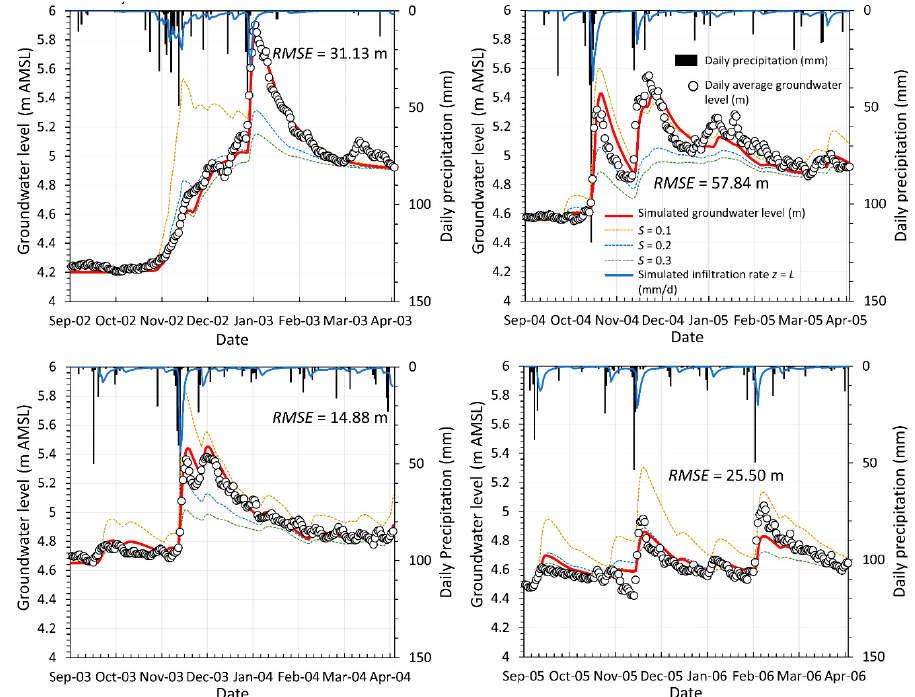
Figure 9. Comparison between the observed daily groundwater level and simulated groundwater level with the optimized values of the kinematic dispersion wave model parameters of a = 3, b = 3.6 × 10 4 mmh − 1 and α w = 200 mm. A red curve indicates the simulated groundwater level obtained using the step function shown in Figure 8 to represent the variation of storage coefficient as a function of the groundwater level. Dashed curves indicate the simulated groundwater level obtained by imposing constant storage coefficients equal to 0.1, 0.2 and 0.3 instead of the step function shown in Figure 8.